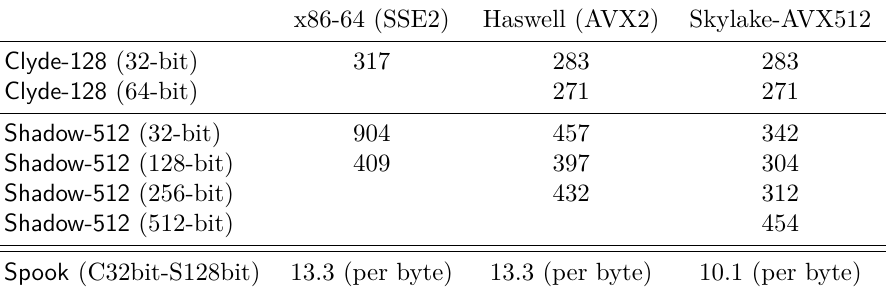
Table 6: High-end software performance results. Number of cycles compiled for various micro-architectures, and throughput (cycles per byte) for a message of 2048 bytes.